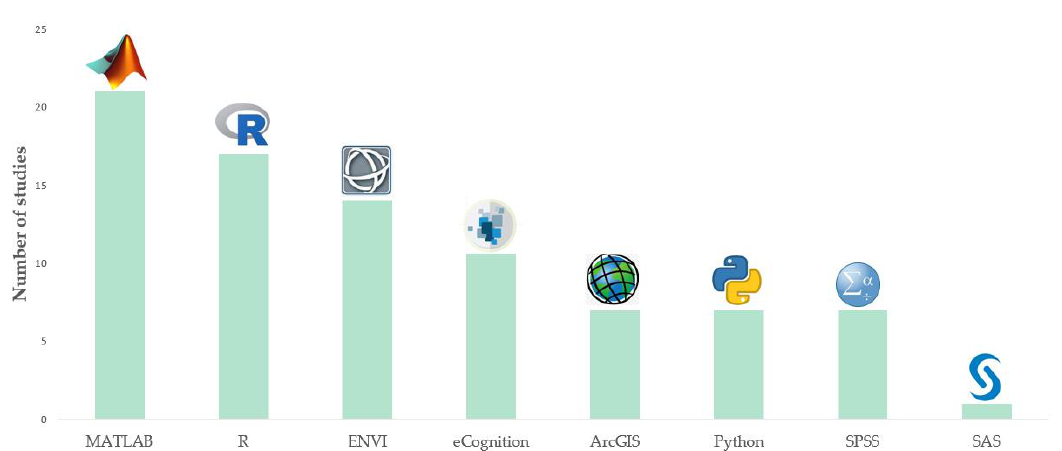
Figure 15. Number of studies in terms of machine learning and statistical software.